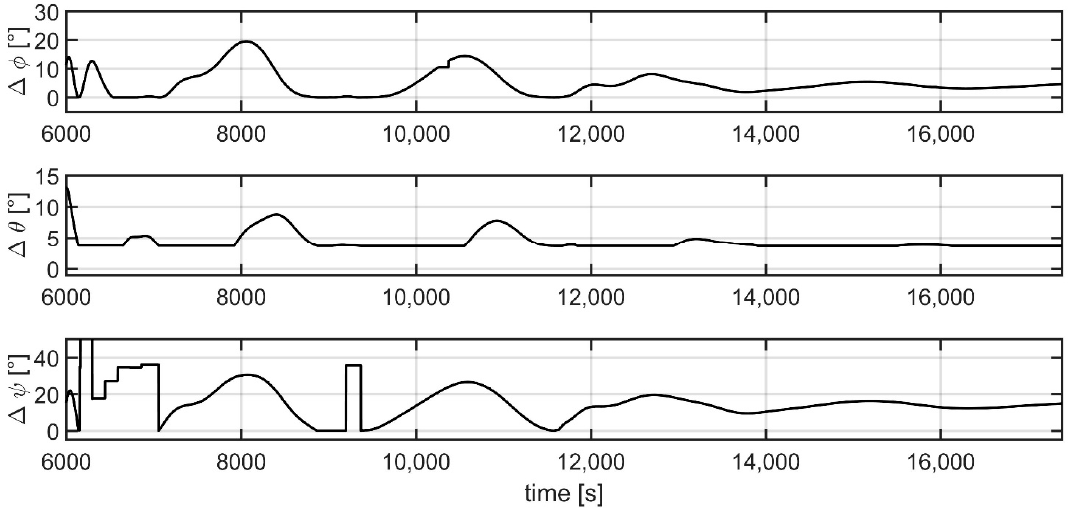
9 of 21 Figure 2. Difference between the actual and estimated Euler angles for Test Case 1.